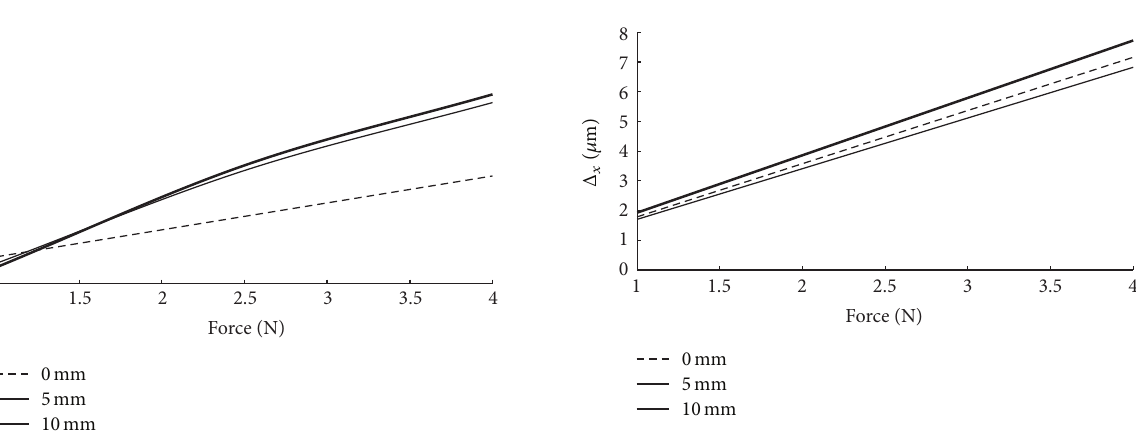
Figure 3: Variation of stress at x -direction for FCR of Model I under the position angle of 34 ∘ .